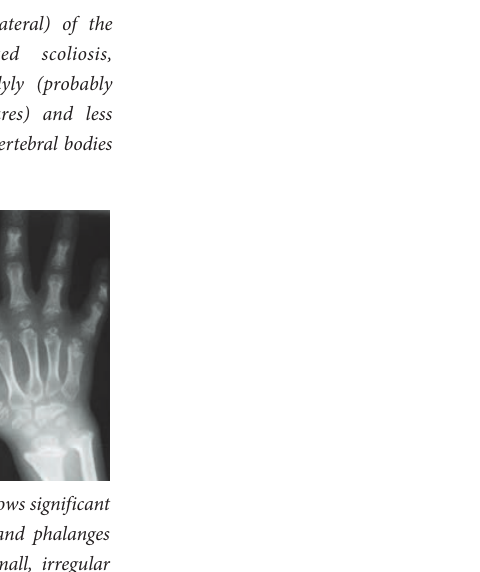
Fig. 7. Proband’s AP hand X-ray shows significant brachydactyly, short metacarpals and phalanges with irregular metaphyses, and small, irregular carpal